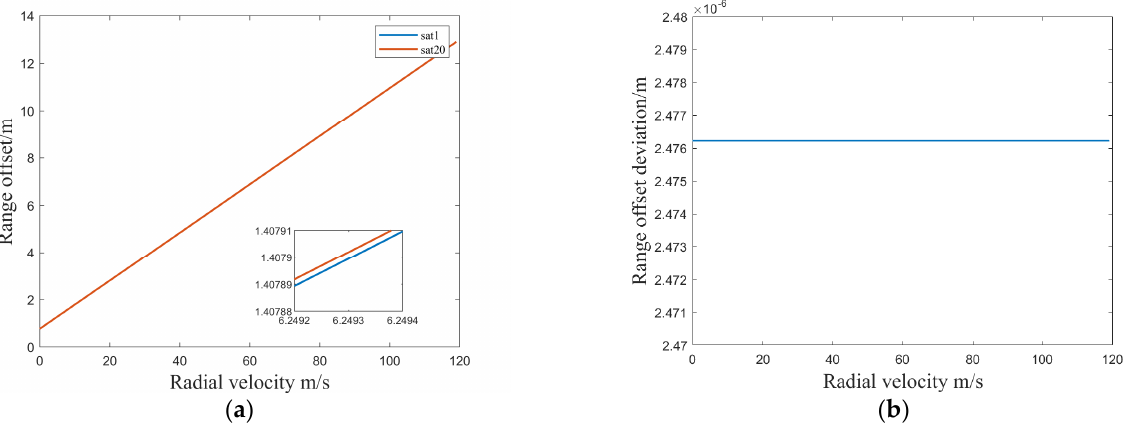
Figure 10. ( a ) Range offset with the radial velocity between the 1st and 20th images; ( b ) range offset deviation with the radial velocity between the 1st and 20th images.